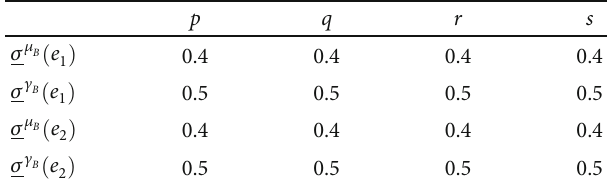
Table 18: Intuitionistic fuzzy set B